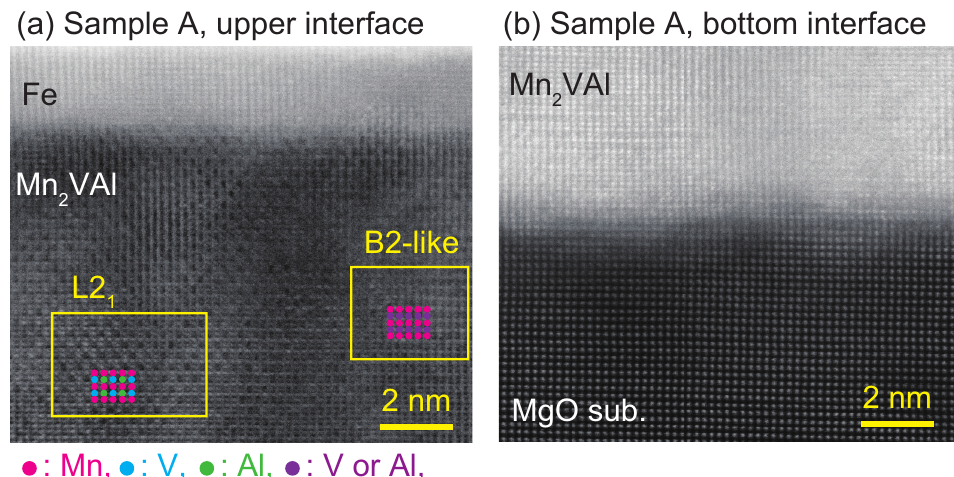
Figure 3. HAADF-STEM images of Sample A around ( a ) the upper Mn 2 VAl/Fe, and ( b ) the bottom MgO/Mn 2 VAl interfaces. Around the upper interface shown in ( a ), periodic contrast changes are observed for the Mn 2 VAl, which represent the L2 1 phase and B2-like partially disordered phase. Around the bottom interface shown in ( b ), the entire area is the disordered A2